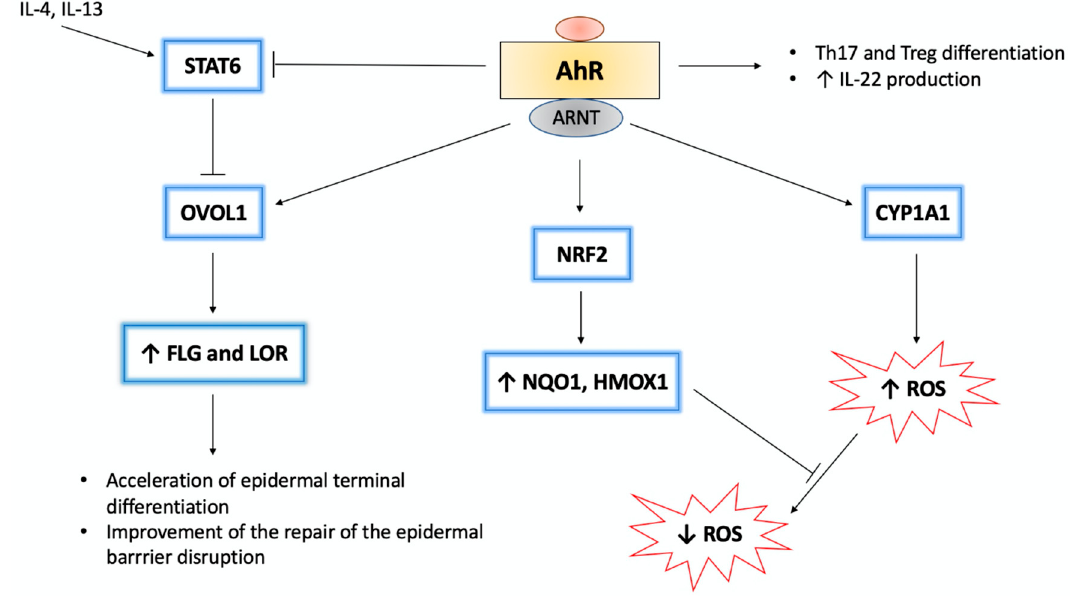
Figure 2. Molecular interactions within the AhR signaling pathway [99]. In the nucleus, AhR/ARNT complex binds to the XRE sequence, thus initiating the transcription of AhR-responsive genes, such as CYP1A1 . CYP1A1 activity is associated with ROS production. Furthermore, AhR ligands are degraded by CYP1A1. Regarding chemically stable ligands, such as dioxins, sustained CYP1A1 activation leads to enhanced ROS generation. On the other hand, several AhR ligands activate nuclear factor-erythroid 2-related factor-2 (Nrf2), a transcription factor, which induces expression of antioxidative enzymes (e.g., heme oxygenase 1 (HMOX1) and NQO1). Moreover, AhR signaling is associated with the differentiation of immune cells, such as Th17 and Treg. Regarding inflammatory skin diseases, such as psoriasis and atopic dermatitis, AhR-mediated IL-22 production plays a crucial role in alleviating skin lesions. AhR/ARNT interaction upregulates filaggrin (FLG) and loricrin (LOR) expression via activation of the OVO-like 1 (OVOL1) transcription factor. Both FLG and LOR play a key role in epidermal differentiation. However, IL-4/IL-13-mediated signal transducer and activator of transcription 6 (STAT6) activation inhibits the OVOL1/FLG/LOR pathway. AhR stimulation may inhibit STAT6 and upregulate FLG and LOR expression. The pathogenic implication of AhR signaling in inflammatory skin diseases is not fully understood as the activation of the AhR/OVOL1/FLG/LOR pathway may become harmful. As the use of rapid metabolizing AhR ligands, such as FICZ, may alleviate skin inflammation, sustainable activation of this pathway by dioxins exacerbates epidermal barrier dysfunction. The scheme is based on previously reported data [9,10,84,99]. ↑ -activation, upregulation, ↓ -downregulation,